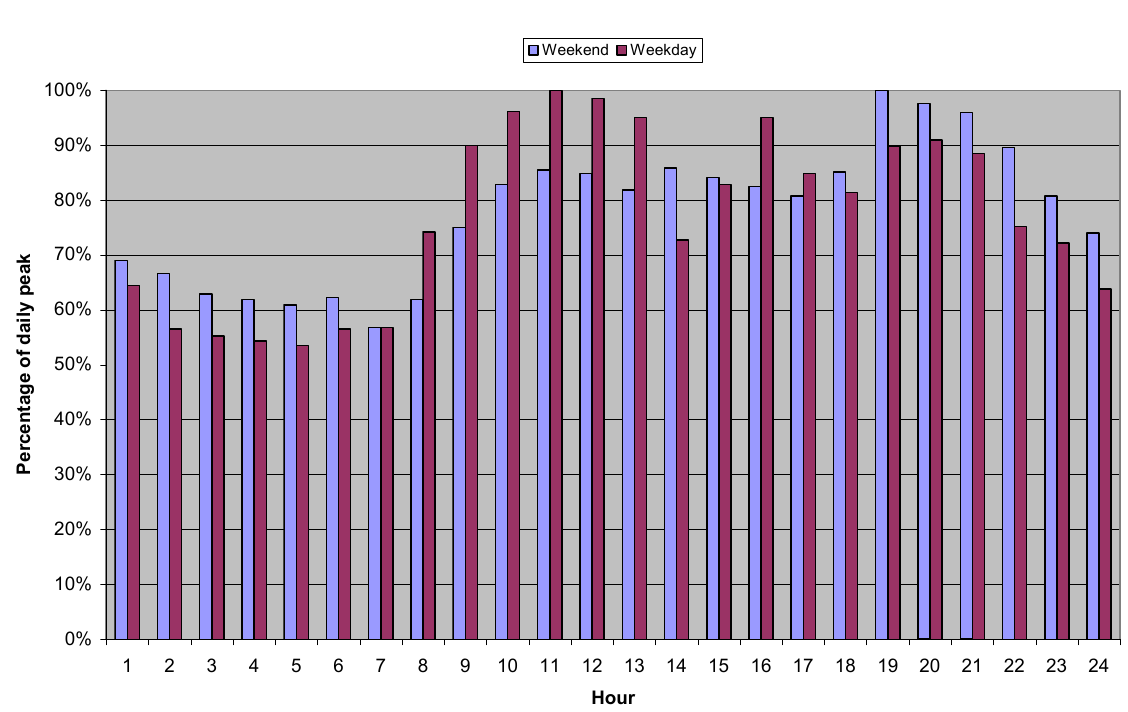
Figure 4. Hourly-load profile of Sabah electrical grid.